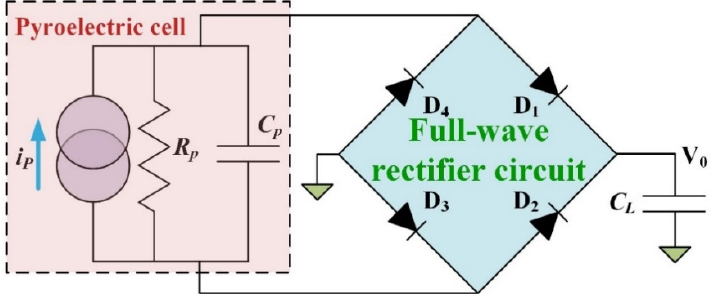
Figure 3. Full-wave rectifier circuit used to store the induced charge from the pyroelectric